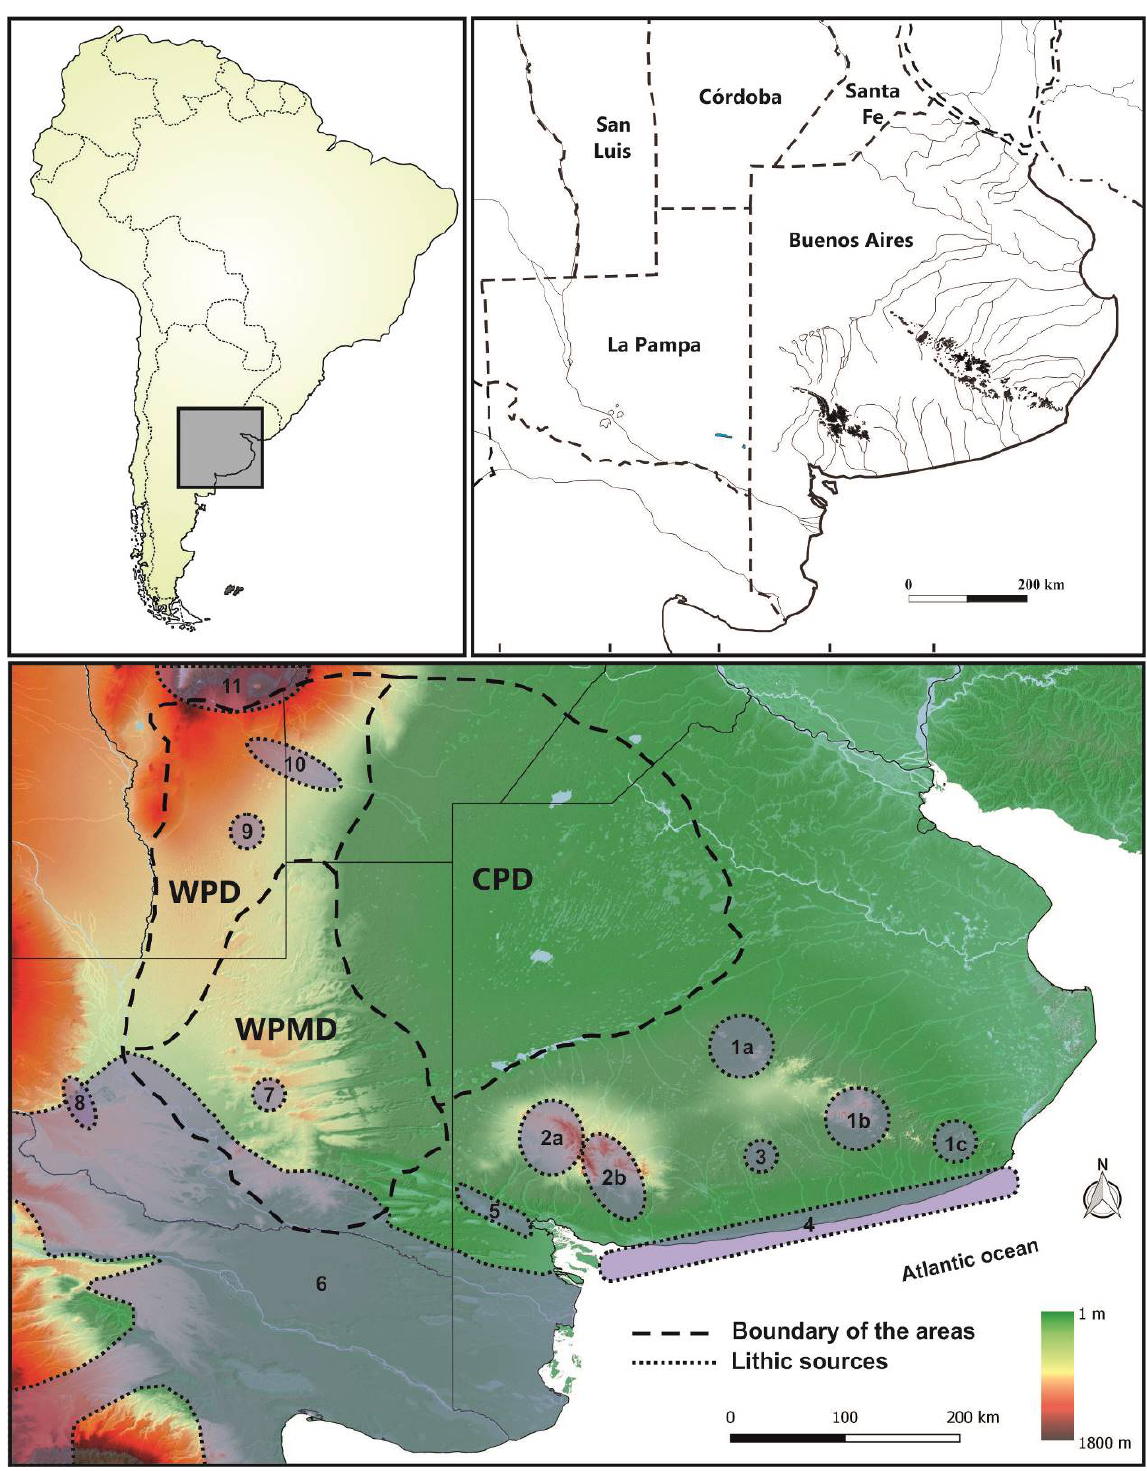
Figure 1. Location of the Aeolian areas and regional base of lithic resources and potential sources of raw material in the center-east of Argentina. CPD. Central Pampean Dunefields; WPD. Western Pampean Dunefields; WPMD. Western Pampas Sand Mantles and Dunefields; 1a. northwestern sector of Tandilia Hill (orthoquarzite of the Sierras Bayas Group and Balcarce Formation, chert from the Cerro Largo Formation, silicified dolomite, quartz, and granites); 1b. central-eastern sector of Tandilia Hill (orthoquarzite from the Sierras Bayas Group, chert, microcrystalline silicates, silicified dolomite, and diabases); 1c. south-eastern sector of Tandilia Hill (orthoquarzite of the Balcarce Formation and quartz); 2a. Ventania Hill (metaquartzite and rhyolite of La Mascota, La Lola, Trocadero and Napostá Formations, orthoquartzite from the Red